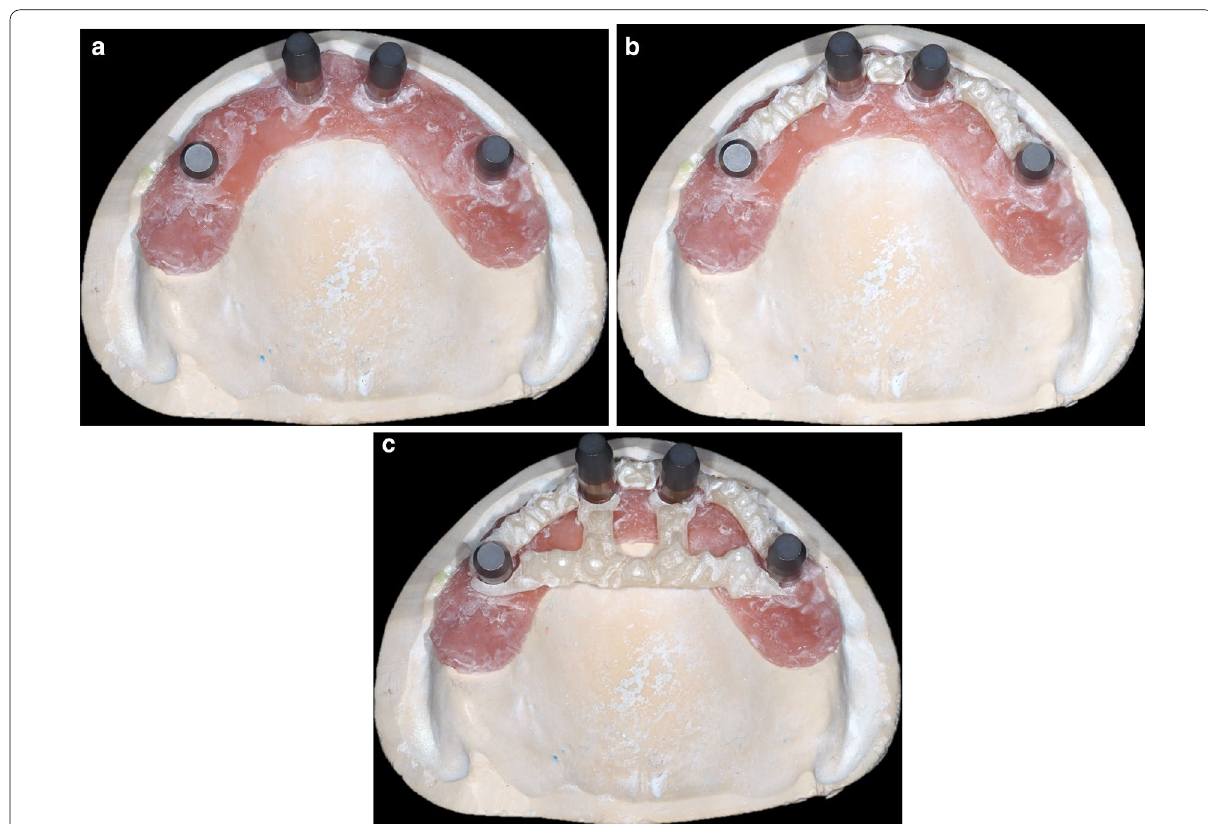
Fig. 1 Designs of the assistive devices in the digital impression group. a Type 0: Reference model with attached scan bodies, without an assistive device. b Type 1: Reference model with an assistive device connecting only neighboring scan bodies, namely between #12–15, #12–22, and #22–25. c Type 2: Reference model with assistive device and the same connections as Type 1, along with a connection between two posterior implants and two perpendicular branches towards the two anterior